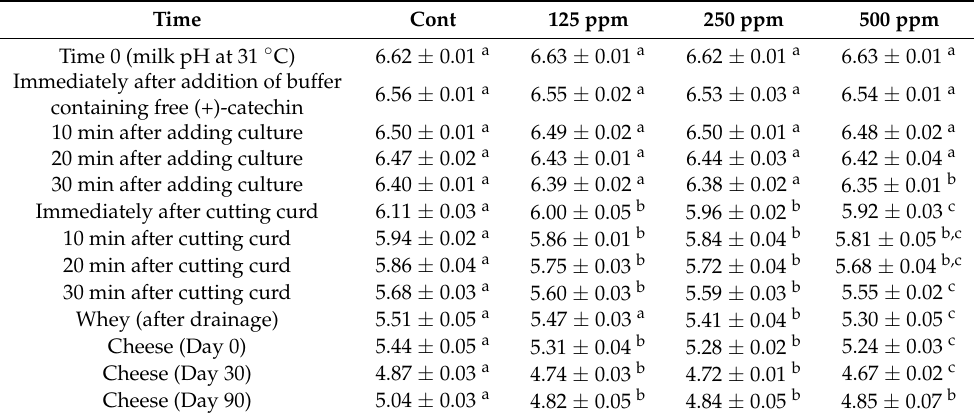
Table 1. Effect of different concentrations of free (+)-catechin on the pH of full-fat cheese during the manufacturing process, as well as the ripening